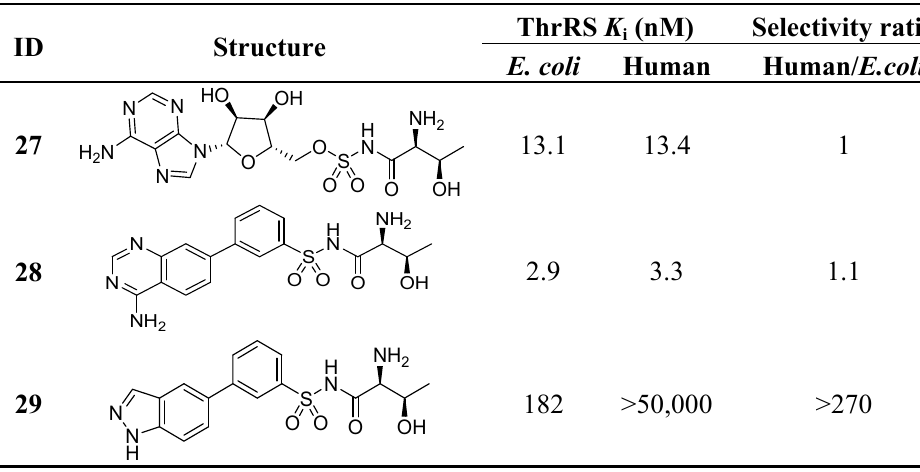
Table 3. Inhibitors of threonyl-tRNA synthetase.